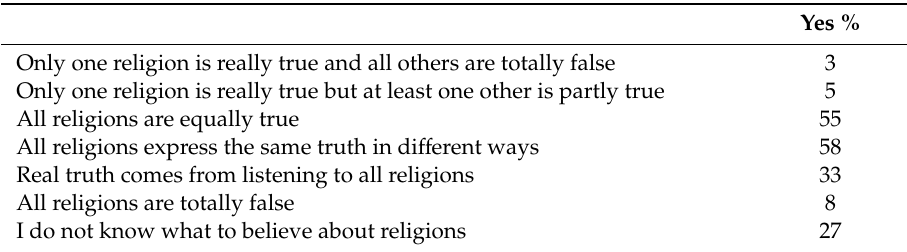
Table 3. Theologies of